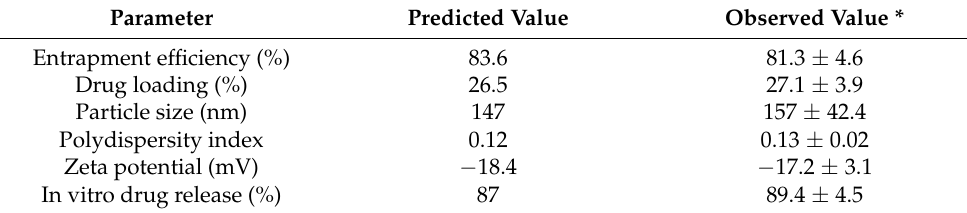
Table 8. Evaluation of optimized solid lipid nanoparticle batch